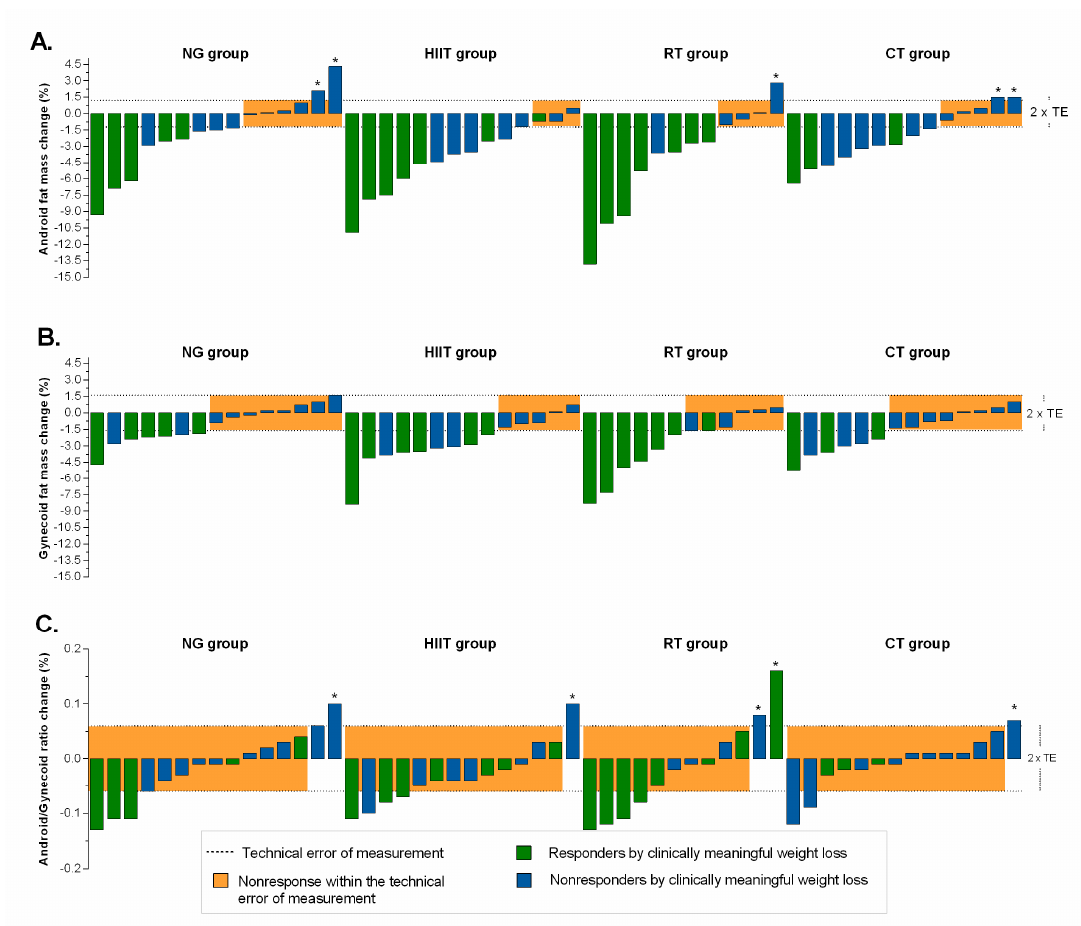
Figure 3. Individual change by intervention group based on fatness indexes. (Panel A ): arms fat mass; (Panel B ): trunk fat mass; and (Panel C ): legs fat mass. The TE for each measurement (see “Methods” section for 2 × TE calculation) is illustrated by the lighter shaded area. Dashed lines represent the TE, while an individual falling within the shaded area would have demonstrated a nonresponse for both variables. Responders by clinically meaningful weight loss ( ≥ 5%) is illustrated by the green bar. Individual changes in blue bar represent nonresponse by clinically criterion weight loss (< 5%). group; CT: combined training (HIIT + RT) group.